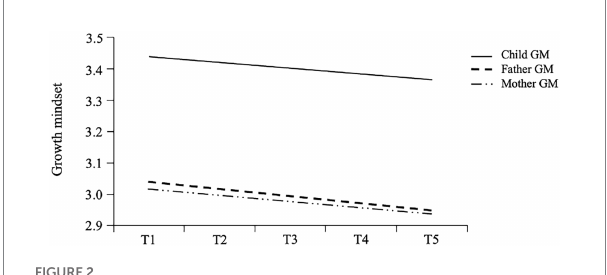
FIGURE 2 The developmental trajectory of growth mindset. GM, growth